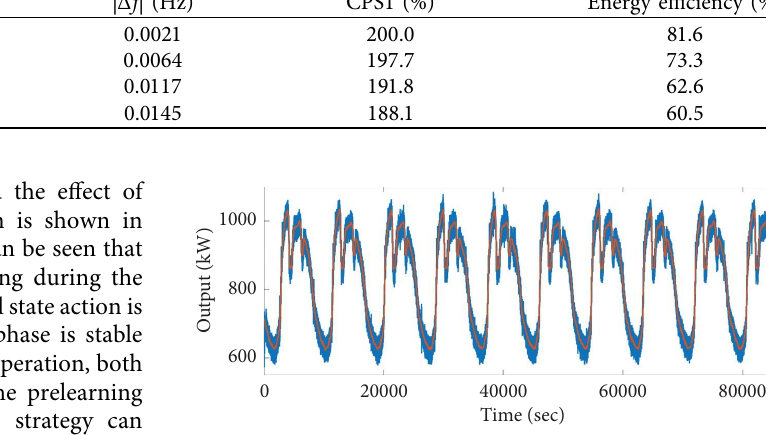
Figure 7: Control performance of four strategies under white noise.